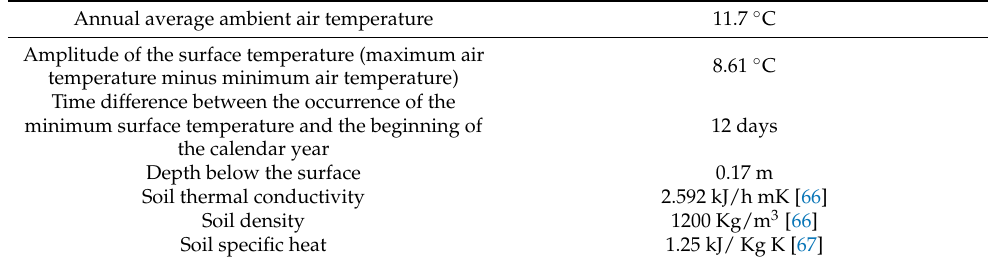
Table 4. Input data for the case study.